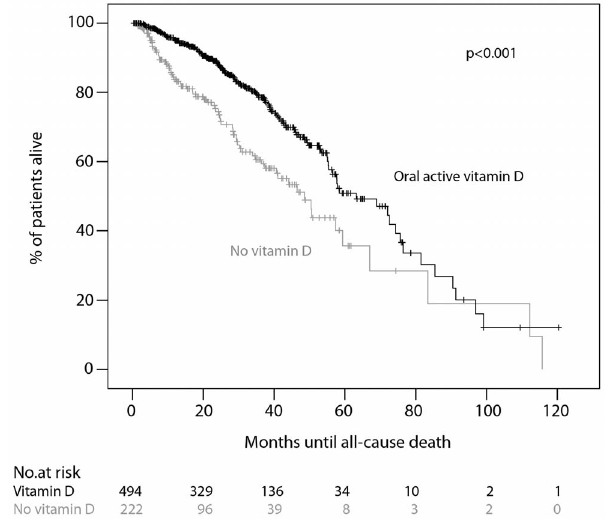
Figure 2. Kaplan-Meier analysis of survival. Survival curves of patients treated with oral active vitamin D at start of PD (black, n=494) were compared with untreated patients (grey, n=222). Data on vitamin D treatment were available for n=716 patients.